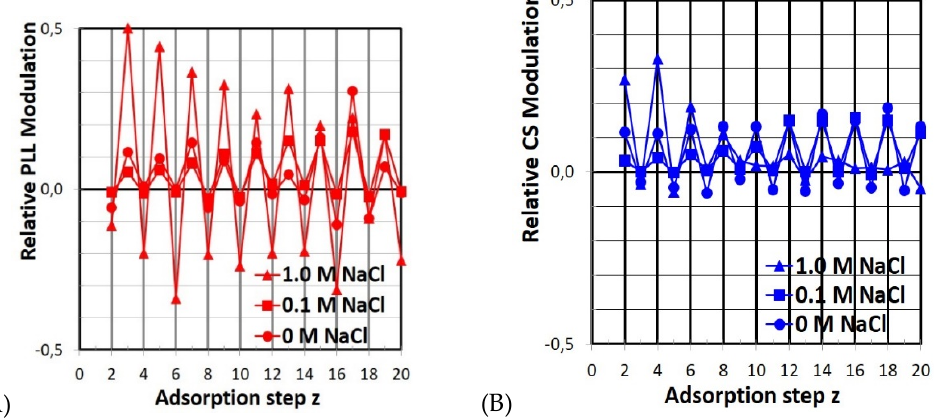
Figure 4. Increases and decreases of relative PLL ( A ) and CS portions ( B ) in relation to adsorption step z with respect to preceding z–1 for z = 2 to 20 (PEM ‐ 2 to PEM ‐